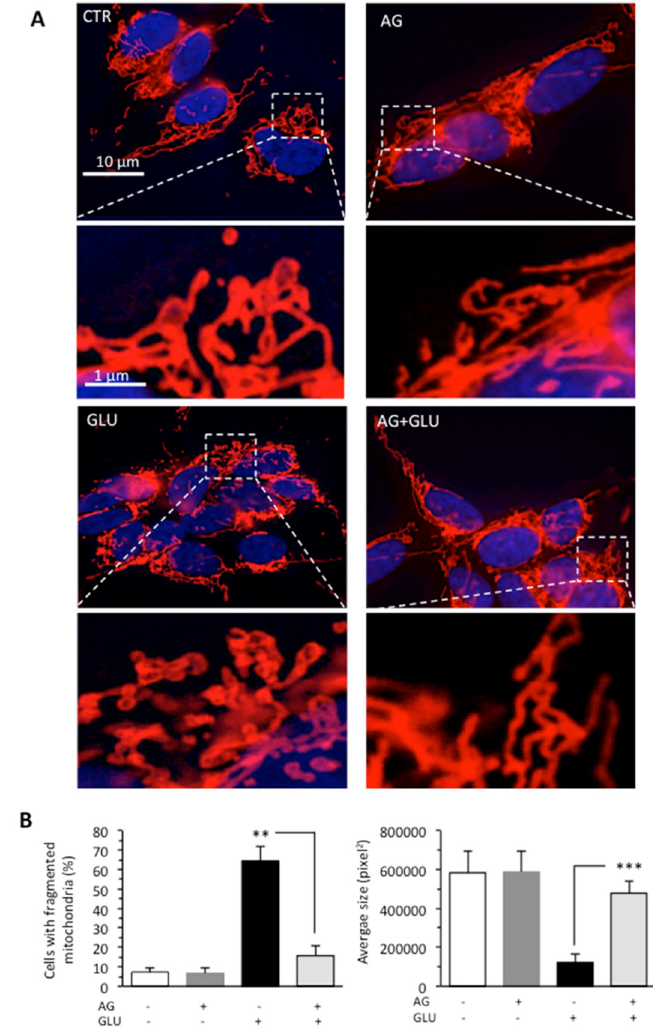
Figure 3 . SH-SY5Y neuroblastoma cells were treated with 300 mM GLU or MAN alone or in combination with 1000 µ g/mL AG for 48 h. ( A ) Representative micrographs obtained by IVM showing the mitochondrial network of SH-SY5Y neuroblastoma cells, untreated (CTR) or treated for 48 h with 100 mM GLU with or without AG, after staining with anti-TOM20 (red) and counterstaining with Hoechst (blue). In the bottom pictures, magnification of the boxed areas. ( B ) Left panel. Bar graph showing the percentage of cells in which fragmented mitochondria were observed. Right panel. Morphometric analysis performed by using the ImageJ software. In ordinate average mitochondrial area is expressed as pixel 2 . Data are reported as mean value ± SD of the results obtained by analyzing at least 50 cells for each sample. ** is for p < 0.01, and *** is for p < 0.001.